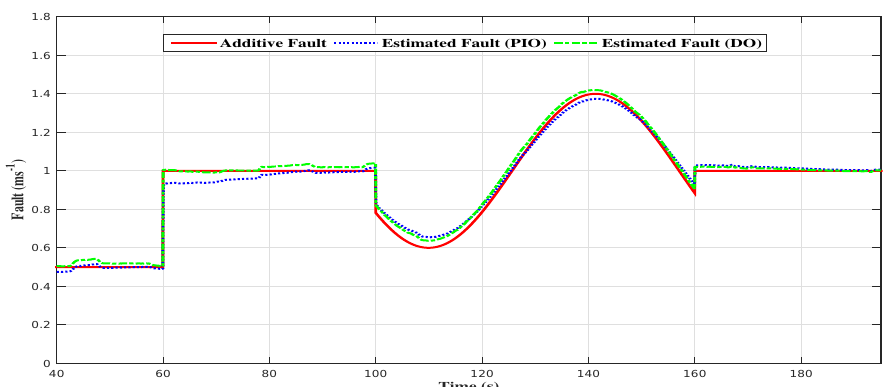
Figure 12. Comparison of the estimated additive fault with the two observers.